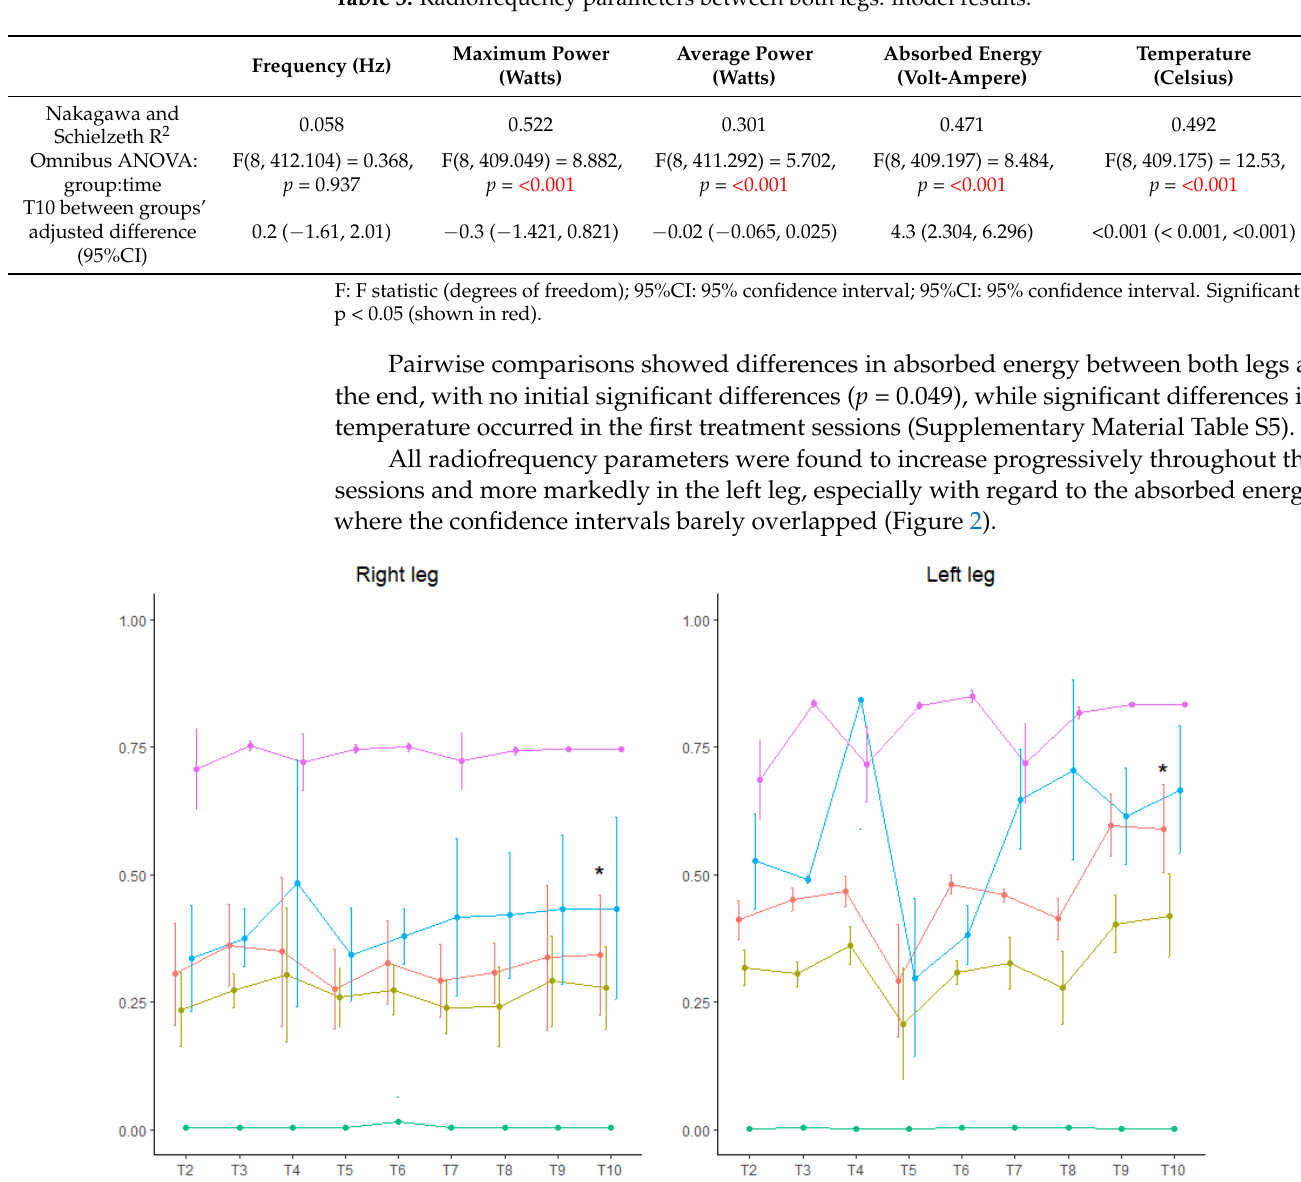
Figure 3. Subjective perception (standardized mean and standard deviation error bars).